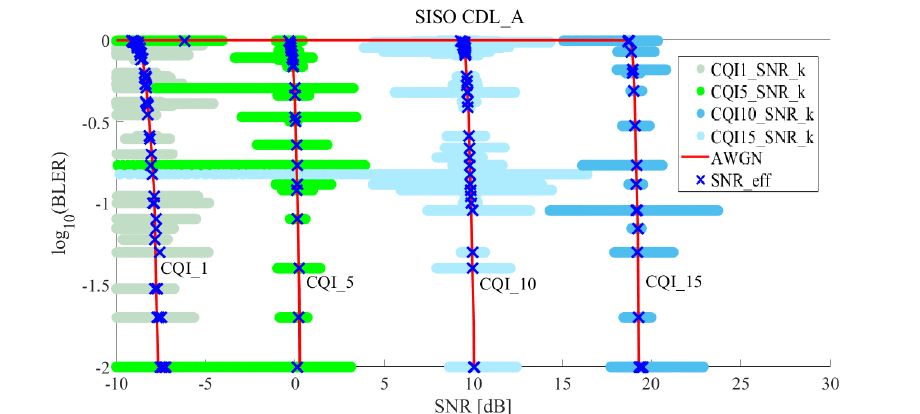
Figure 7. Effective SNR mapping results of the proposed ML-based EESM method under 5G CDL-A SISO (for CQI1, CQI5, CQI10, and CQI15).